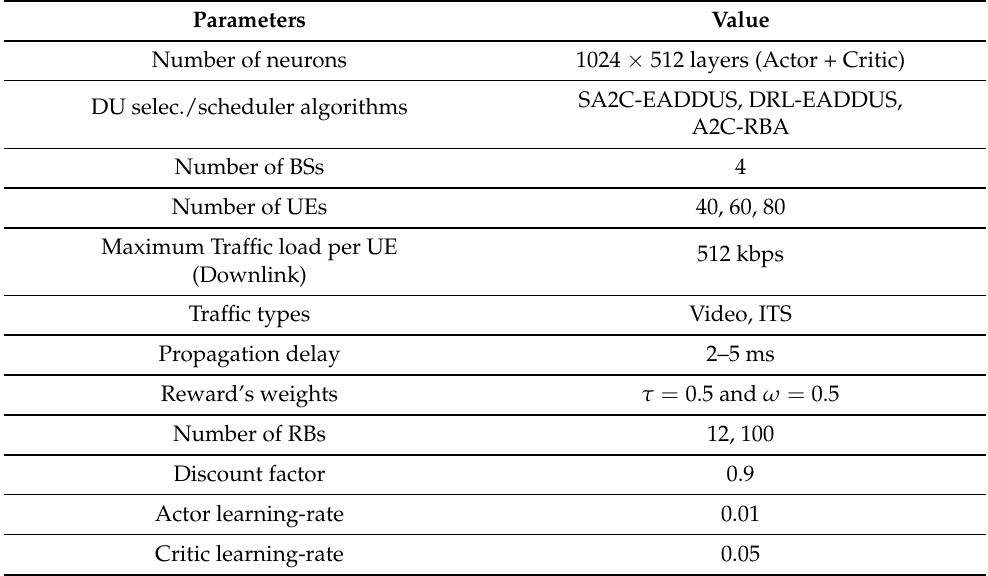
Table 2. Simulation